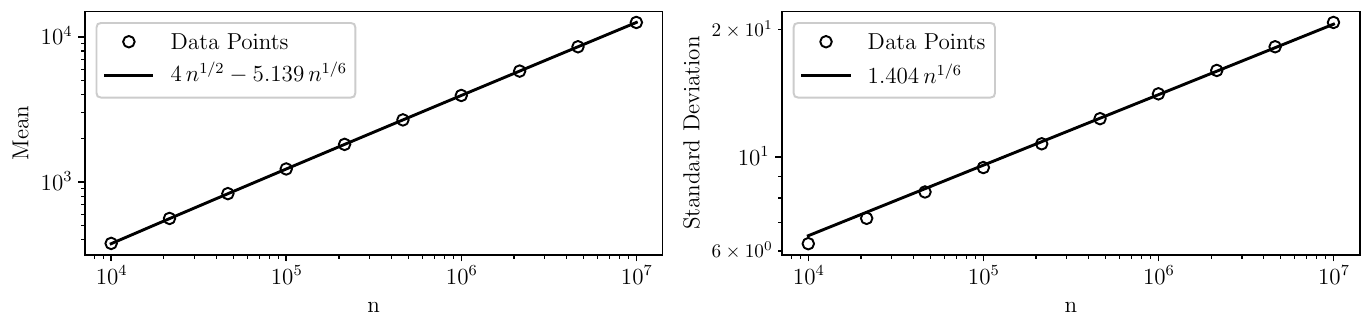
Figure 1: Log-Log plots of the best fits for the mean and standard deviation of the number of particles in two-aligned segments. The data indicate that E ( p I ) 4 n 1 / 2 + a n 1 / 6 and SD ( p I n ≈ [ 5 . 222 , 5 . 057] and b [1 . 392 , 1 . 417] with corresponding MSEs 1 . 054 and 0 . 024 , respectively. − − ∈